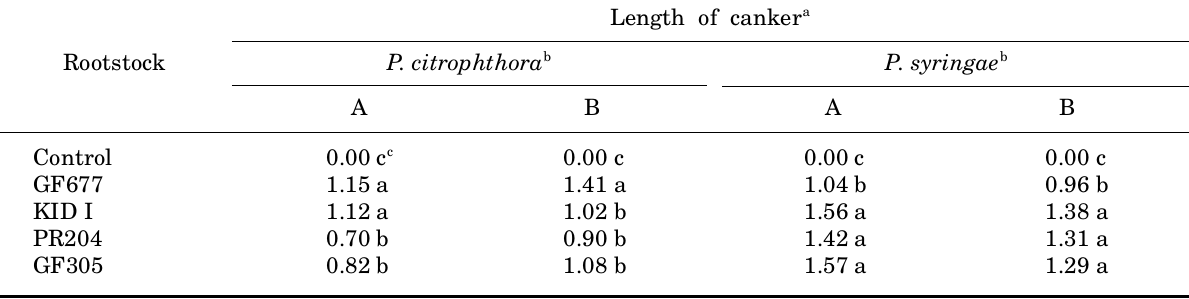
Table 1. Susceptibility to Phytophthora citrophthora and P. syringae as shown by canker length on four peach rootstocks tested by the excised twig